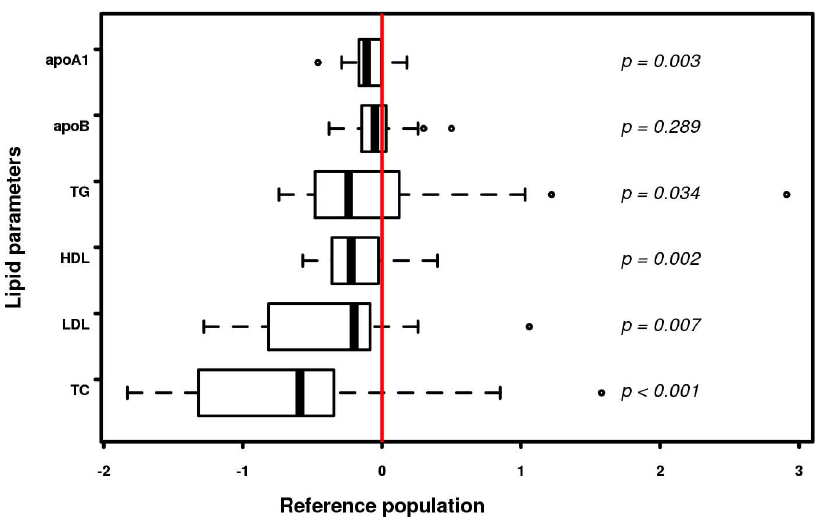
Fig 1. Lipid parameters in FXS males. Distributionof lipid componentsare illustratedwith box and whisker plots, with the bottom and top of the box representingfirst and third quartilesand the band insidethe box the median(the bottom whisker extends to the smallest corresponding concentration from first quartileand top whisker extends to the largest corresponding concentration from third quartile).Lipid componentsare comparedto corresponding reportedlevels in normalpopulation,matched for age and sex (red line) and p- value for difference is shownfor each lipid component.TC: total cholesterol; TG: triglycerides; apoB: apolipoproteinB100;apoA1: apolipoproteinA1.